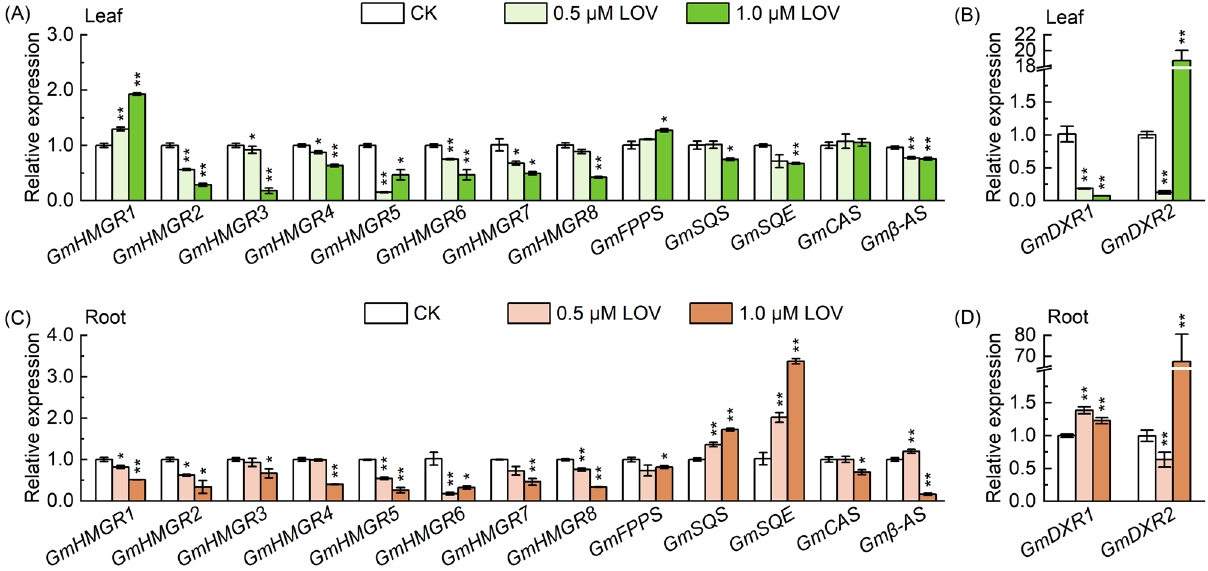
Figure 5. Expression changes of MVA and MEP pathways-related genes in LOV-treated soybean seedlings. ( A ) Transcript levels of HMGR ( GmHMGR1-8 ), Farnesyl diphosphate synthase ( GmFPPS ), Squalene synthase( GmSQS ), Squalene epoxidase ( GmSQE ), Cycloartenol synthase ( GmCAS ), β -amyrin synthase ( Gmβ-AS ), 1-Deoxy-D-xylulose 5-phosphate reductoisomerase ( GmDXR ) in soybean leaves; ( C ) and ( D ) Transcript levels in soybean roots. The data represent the mean ± SE of three biological replicates; the symbol * denotes significant difference from CK at p < 0.05; ** at p < 0.01 by Student’s